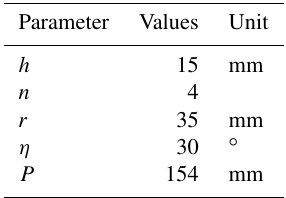
Table 1. Key parameters of the